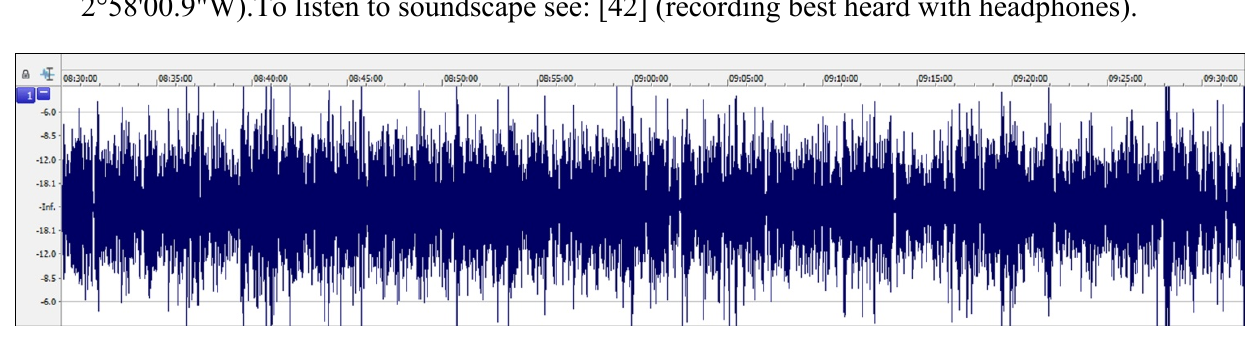
Figure 5. Soundscape map (detail), 2:04 a.m.–2:10a.m., 23 August 2013 (53°18'10.1"N 2°58'00.9"W).To listen to soundscape see: [42] (recording best heard with headphones).